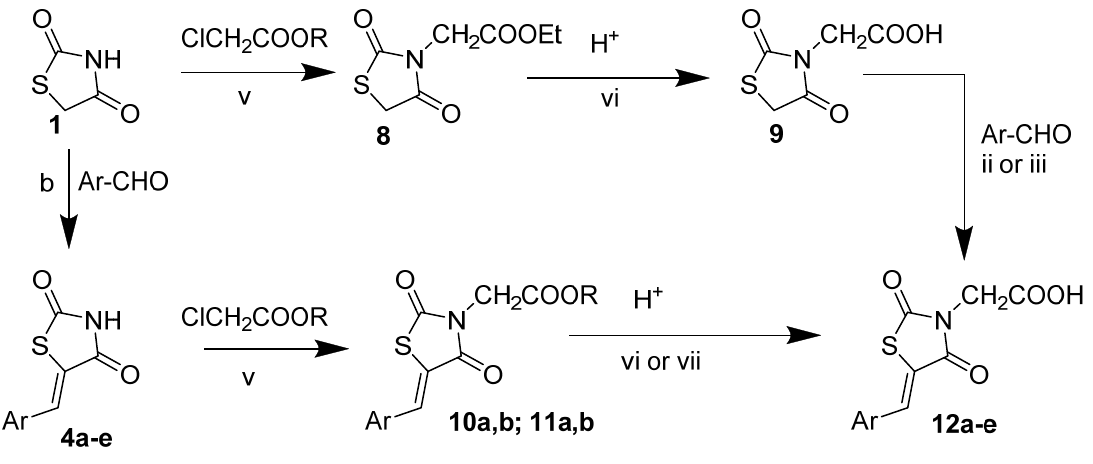
Scheme 4. Synthesis of 2 ‐ (5 ‐ arylidene ‐ 2,4 ‐ dioxothiazolidin ‐ 3 ‐ yl)acetic acid derivatives. Reagents